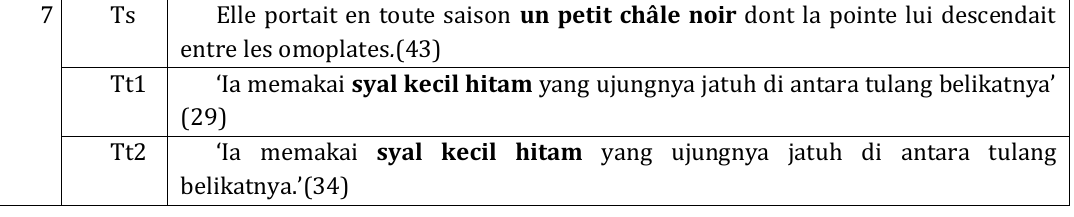
Tableu 8 La technique calque